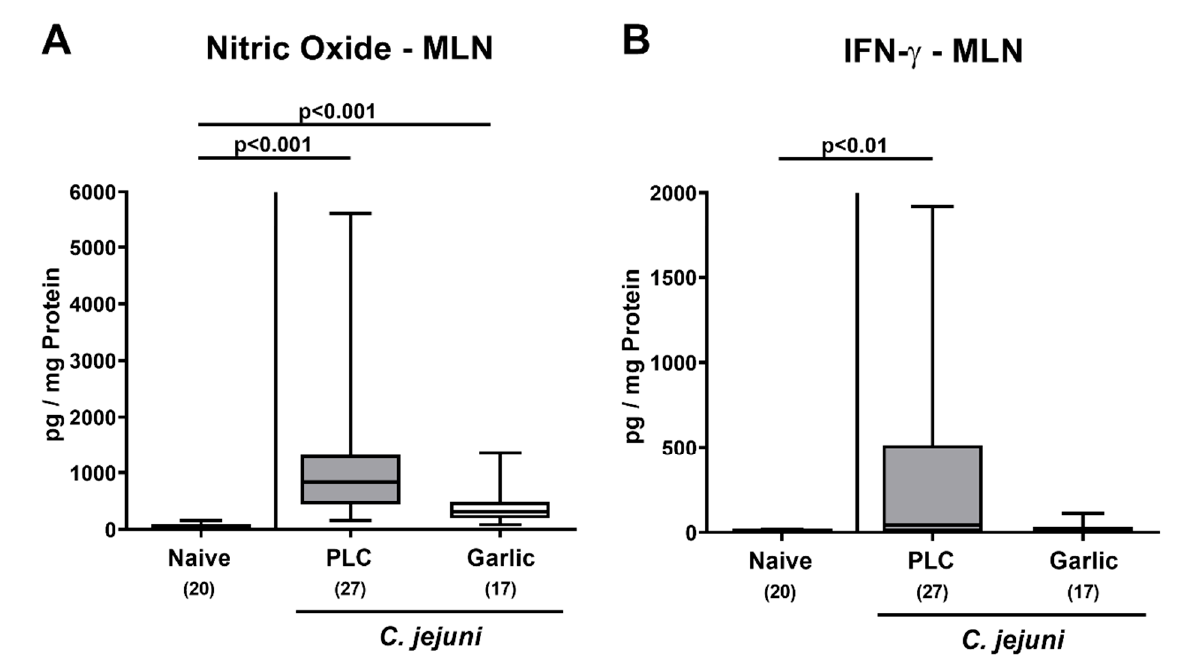
Figure 7. Pro-inflammatory mediator secretion in mesenteric lymph nodes upon garlic essential oil treatment of C. jejuni infected IL-10 -/- mice. Secondary abiotic IL-10 -/- mice were orally challenged with C. jejuni strain 81-176 on days 0 and 1 followed by treatment with either garlic essential oil (white boxes) or placebo (PLC, gray boxes) via the drinking water starting on day 2 post-infection. ( A ) Nitric oxide and ( B ) IFN- γ concentrations were determined in culture supernatants of mesenteric lymph nodes (MLN) explants taken on day 6 post-infection. Naive mice (hatched boxes) served as non- infected and untreated cohort. Box plots (indicating the 25th and the 75th percentiles), whiskers (indicating maximum and minimum values), medians (black bar inside box), significance levels ( p values) determined by the Kruskal-Wallis test and Dunn’s post-correction and the total number of mice (in parentheses) are shown (pooled data from four independent experiments).